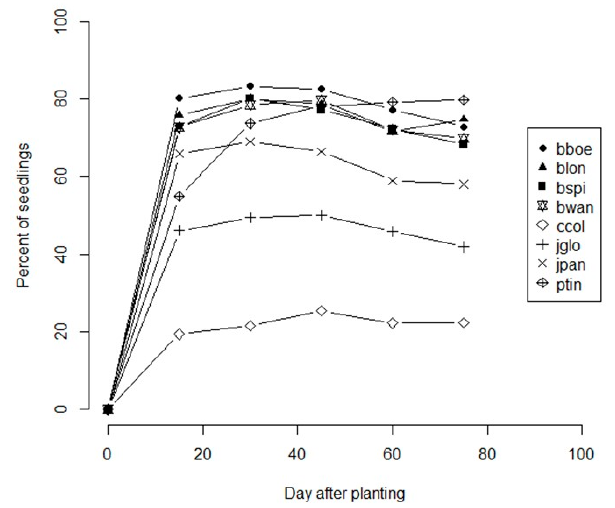
Figure 1. Emergence of seedlings of 8 tree species of woodland, during the rainy season (10 December 2010 to 29 March 2011). ccol: C. collinum and ptin: P. tinctorius (ES); bboe: B. boehmii , blon: B. longifolia , bspi: B. spiciformis , bwan: B. wangermeana , jglo: J. globiflora and jpan: J. paniculata (LS). N = 6 replicates (subplot) per species.